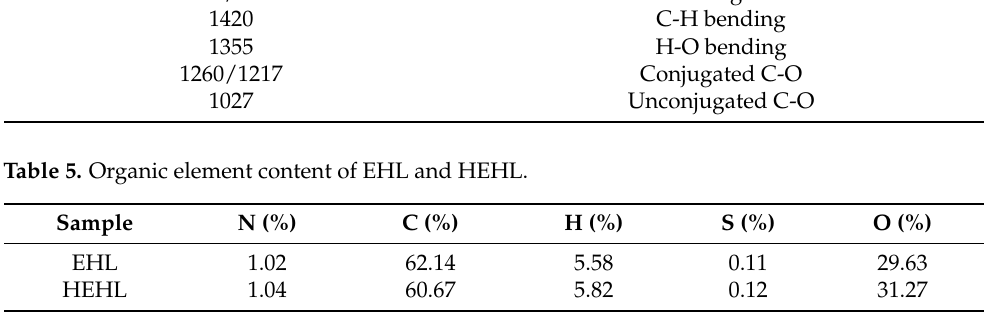
Figure 5. Thermogravimetric analysis of ( a ) EHL and ( b ) HEHL in the temperature range of 30–795 °C with a heating rate of 10 °C/min under nitrogen atmosphere (10 mL/min). The TGA of lignin samples was performed between 30 and 795 °C under a nitrogen atmosphere. The thermal weight loss process of the samples was divided into four stages.